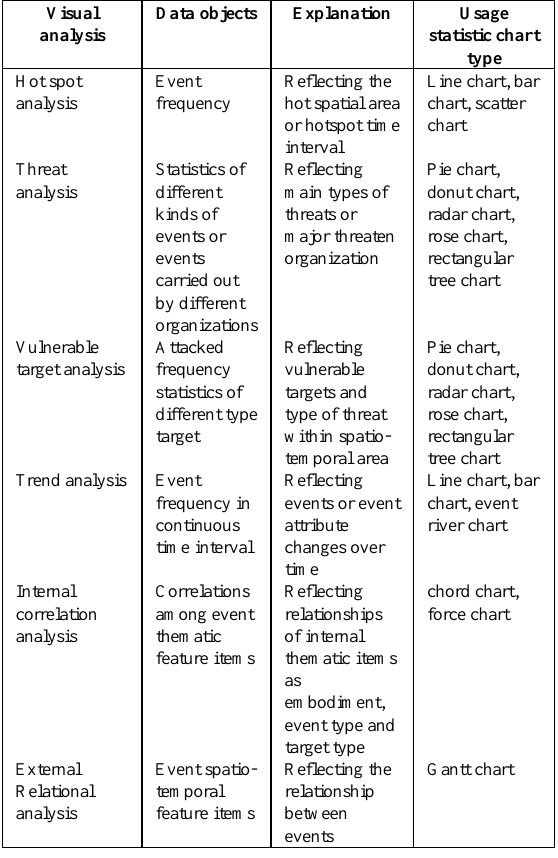
Table 4 Event visual analysis types and suitable statistic charts